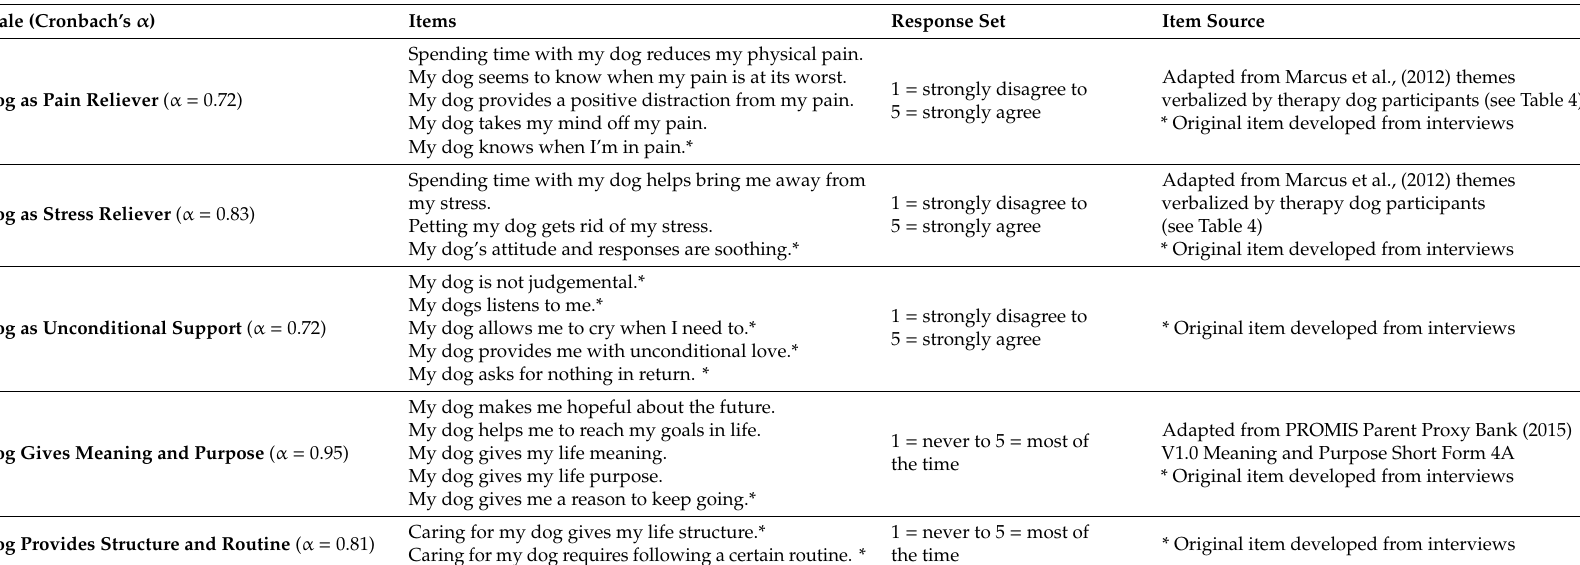
Table 2. Original and Adapted Measures Developed for Dog Owners ( N =